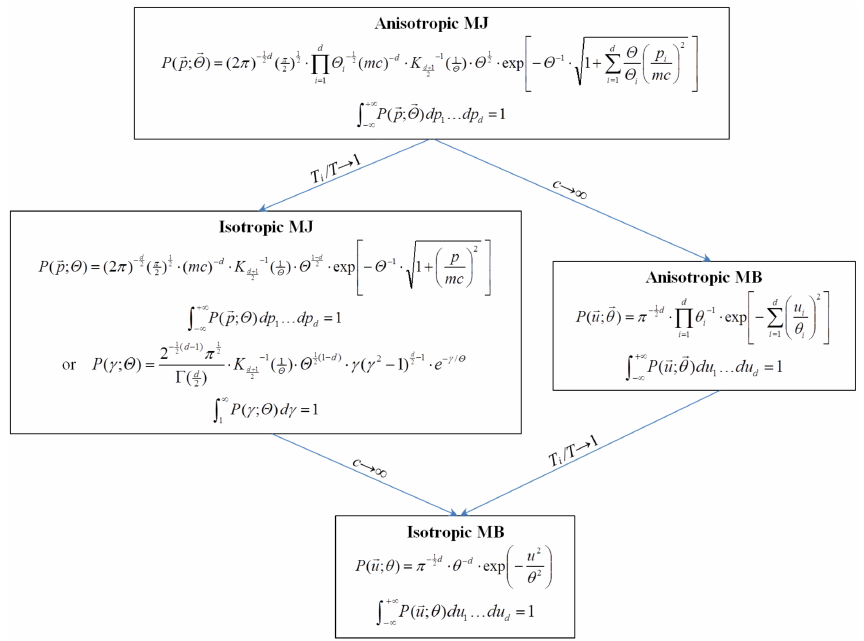
Figure 3. Correspondence of anisotropic Maxwell–Jüttner (MJ) distribution to the isotropic Maxwell–Jüttner and anisotropic Maxwell distributions; we use (cid:50) i ≡ k B T i